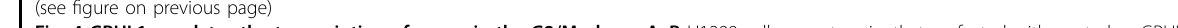
Fig. 4 GRHL1 regulates the transcription of genes in the G2/M phase. A , B H1299 cells were transiently transfected with control or GRHL1 plasmids. Forty-eight hours later, total RNAs were extracted. The mRNA levels were determined by q-PCR. Data represent the average of three independent experiments. * P < 0.05, ** P < 0.01, *** P < 0.001, ns: P > 0.05. C H1299 cells were transiently transfected with control or GRHL1 siRNAs. Forty-eight hours later, total RNAs were extracted. The mRNA levels were determined by q-PCR. Data represent the average of three independent experiments. * P < 0.05, ** P < 0.01, *** P < 0.001. D H292 cells were transiently transfected with control or His-GRHL1 plasmids. Forty-eight hours later, the cells were lysed. Protein expression was assessed by western blotting using the indicated antibodies. E H1299 cells were transiently transfected with control or GRHL1 siRNAs. Forty-eight hours later, the cells were lysed. Protein expression was assessed by western blotting using the indicated antibodies. F In 293 T cells, ChIP assay was conducted with anti-His and control rabbit IgG for immunoprecipitation, followed by PCR with CDC27, RAD21, CDC7, and ANAPC13 promoter-speci fi c primers. G pGL3-enhancer vector containing CDC27, RAD21, CDC7, and ANAPC13 promoter